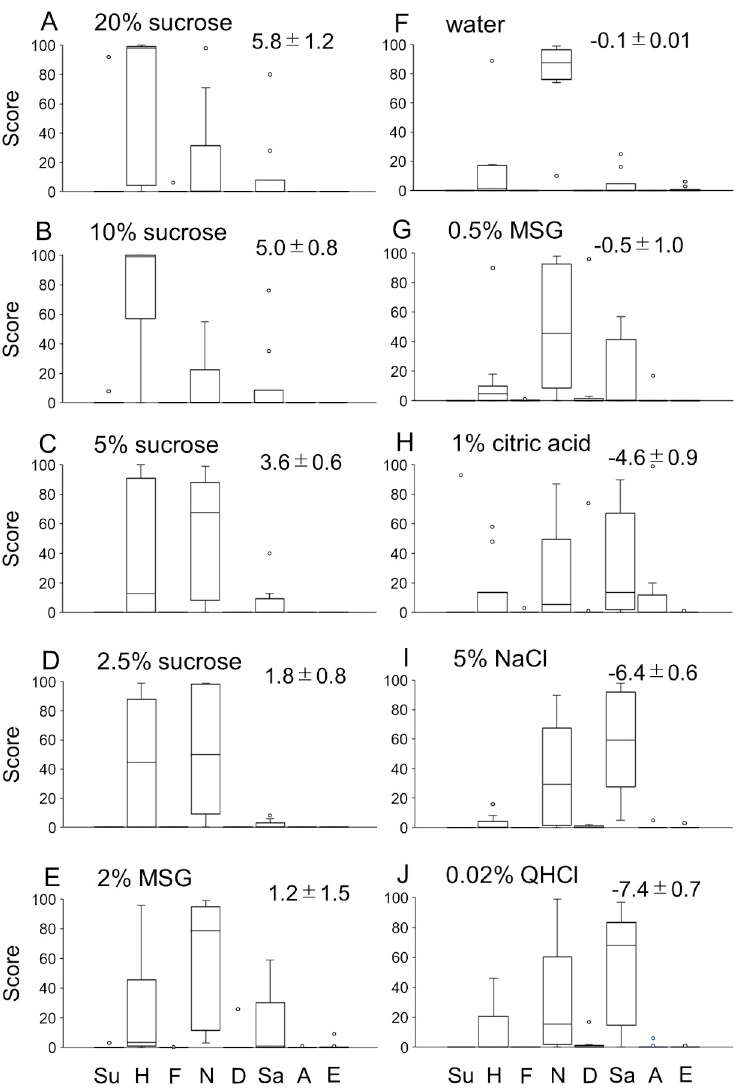
Fig 2. Box and whisker plot analysis of scores for eight different emotions evoked by 10 stimuli. The median and interquartile range with minimum and maximum scores are based on the emotional scores of the 10 participants shown in Fig 1. Small circles in each panel indicate outliers. Graphs are arranged from the most pleasant to the most unpleasant stimulus from A to J, respectively, as shown by the mean ± standard error perceived hedonic rating in each graph. Other descriptions are the same as those in Fig